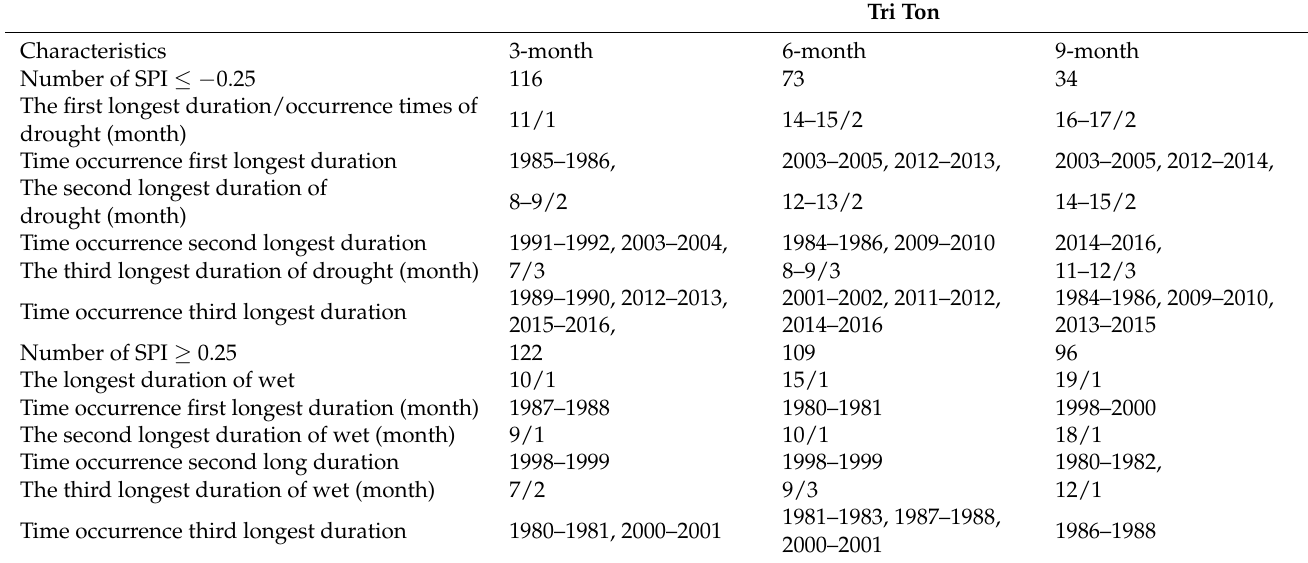
Table 3. SPI values for drought and wet duration in the period of 1980–2019 at Tri Ton meteorologi- cal